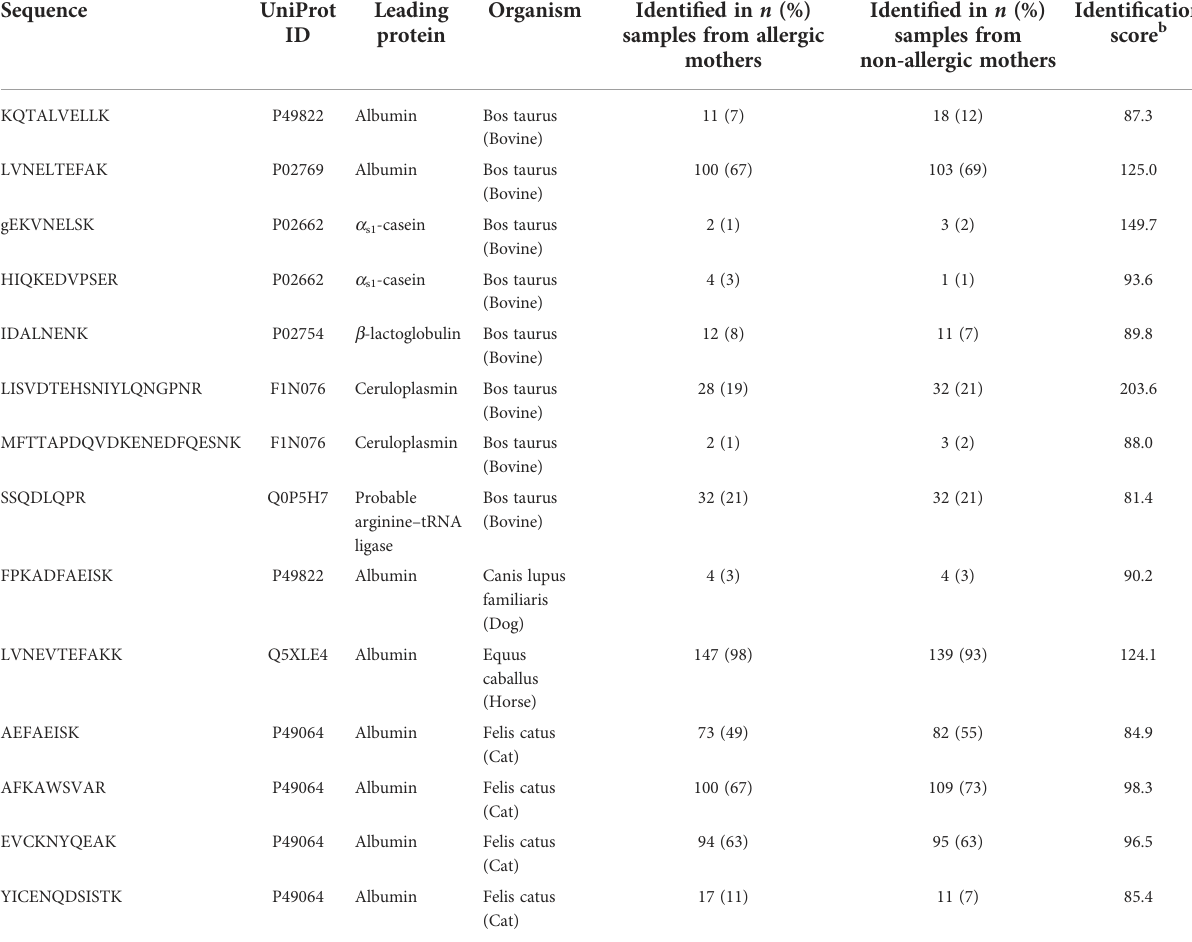
TABLE 2 Identi fi ed non-human tryptic peptides in human milk samples from the CHILD Cohort Study ( n = 150 allergic mothers and 150 non- allergic mothers).